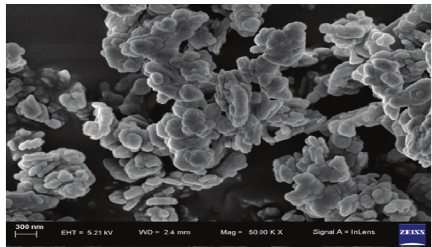
Figure 2: Scanning electron microscopy (SEM) of metakaolin.